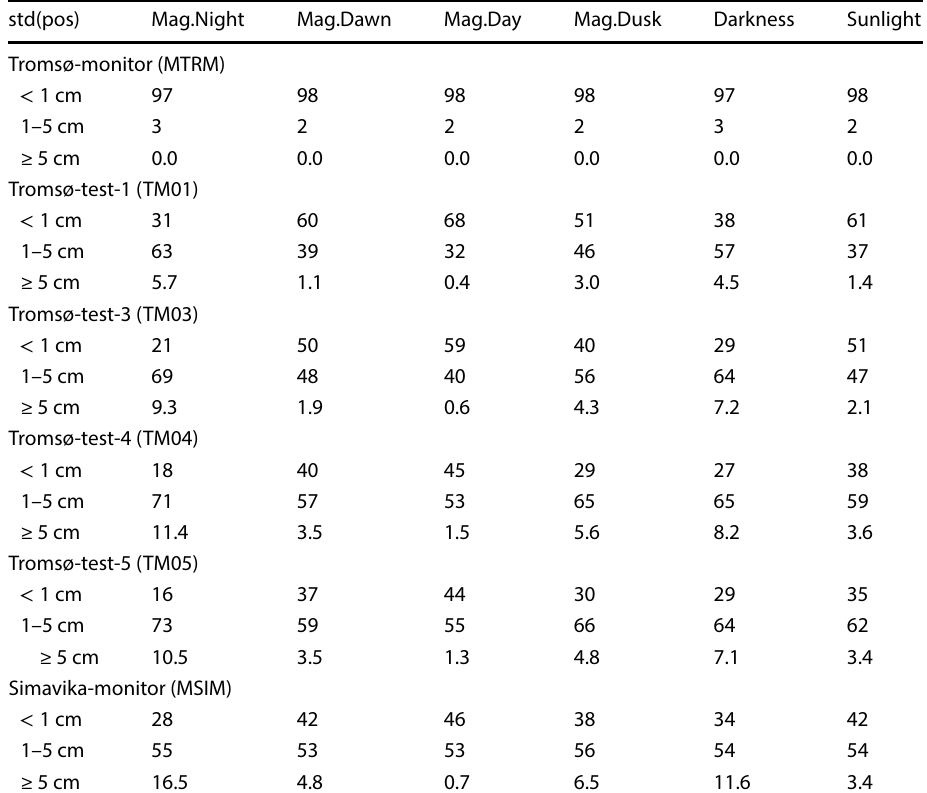
Table 3 Probability for vertical position